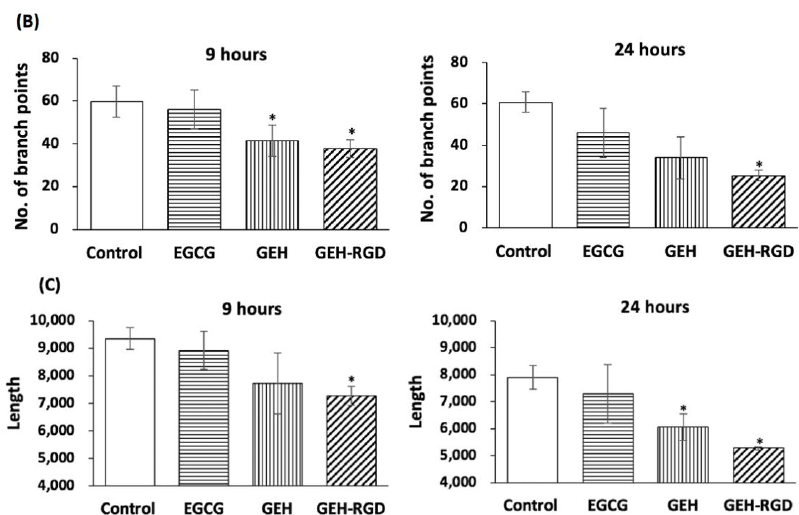
Figure 2. EGCG NPs inhibit endothelial tube formation. ( A ) Representative images of HUVECs cultured on Matrigel at a different time point (EGCG: 20 µg/mL, 100×). The images in each treatment were taken at 9 and 24 h, and ( B ) the number of branch points and ( C ) total length of tubing cells were quantified ( n = 3). * p < 0.05 compared with control. Abbreviation: PBS: Phosphate buffer saline, EGCG: epigallocatechin-3 gallate, HA: hyaluronic acid, RGD: arginine-glycine-aspartic acid, GE: Gelatin/EGCG self-assembling.